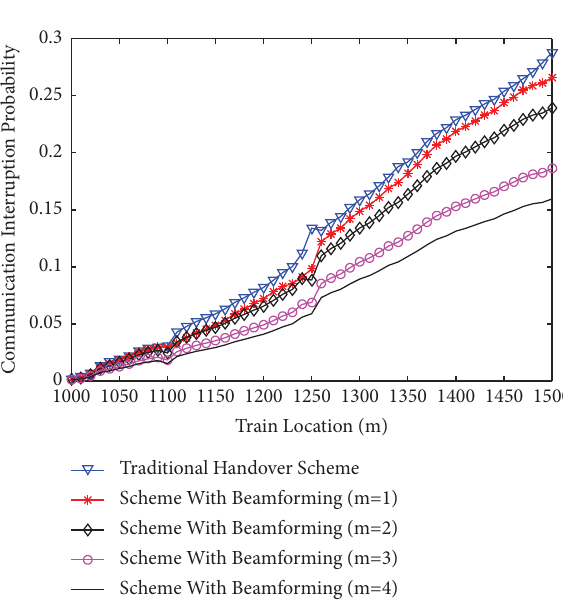
Figure 8: Communication interruption